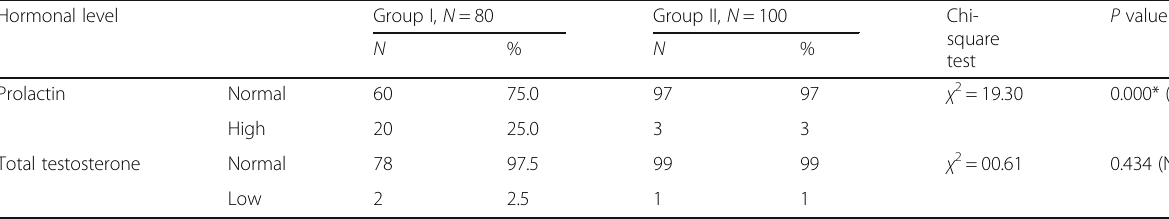
Table 8 Hormonal levels among patients of group I and group II Hormonal